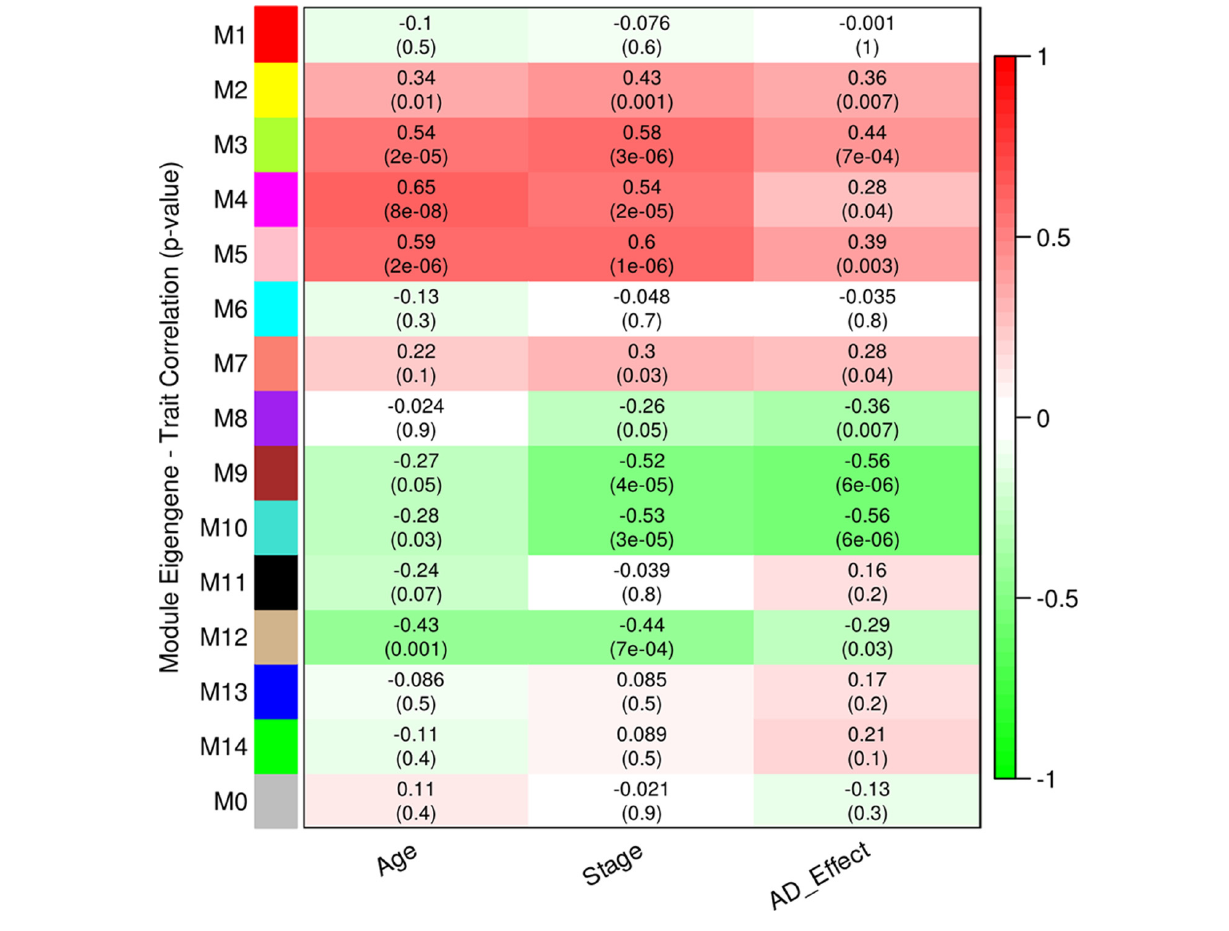
whole tissue: GSE1297, GSE36980, GSE84422, GSE29378